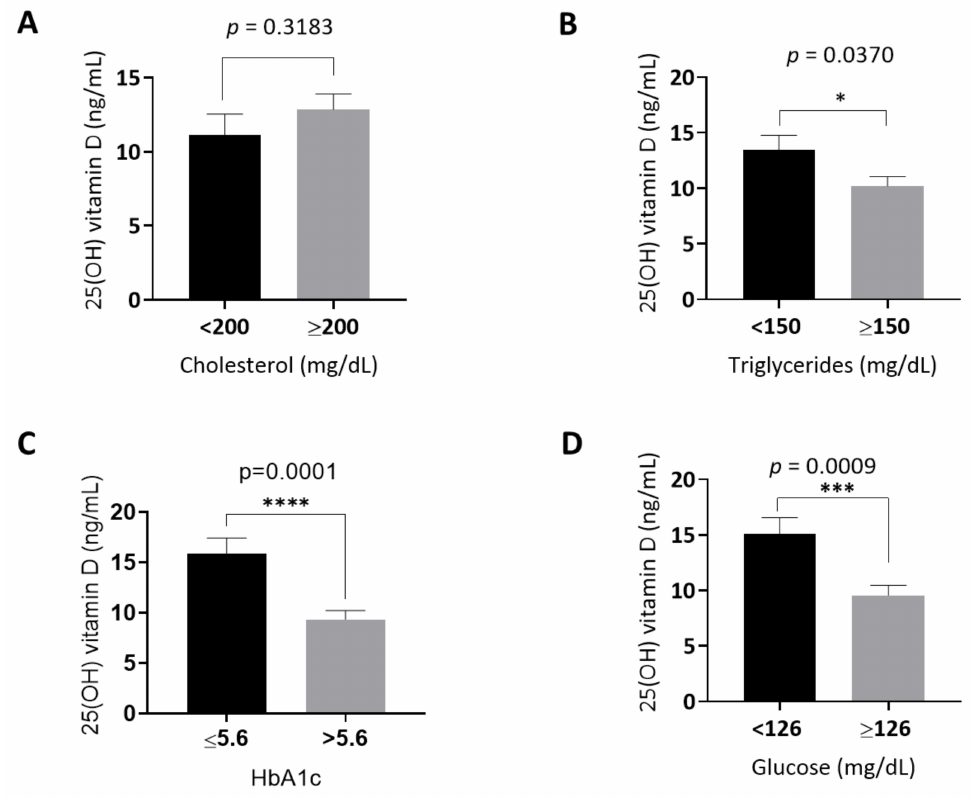
Figure 2. Comparison of serum 25(OH) vitamin D levels in participants who had high versus normal levels of ( A ) cholesterol, ( B ) triglycerides, ( C ) HbA1c, and ( D )